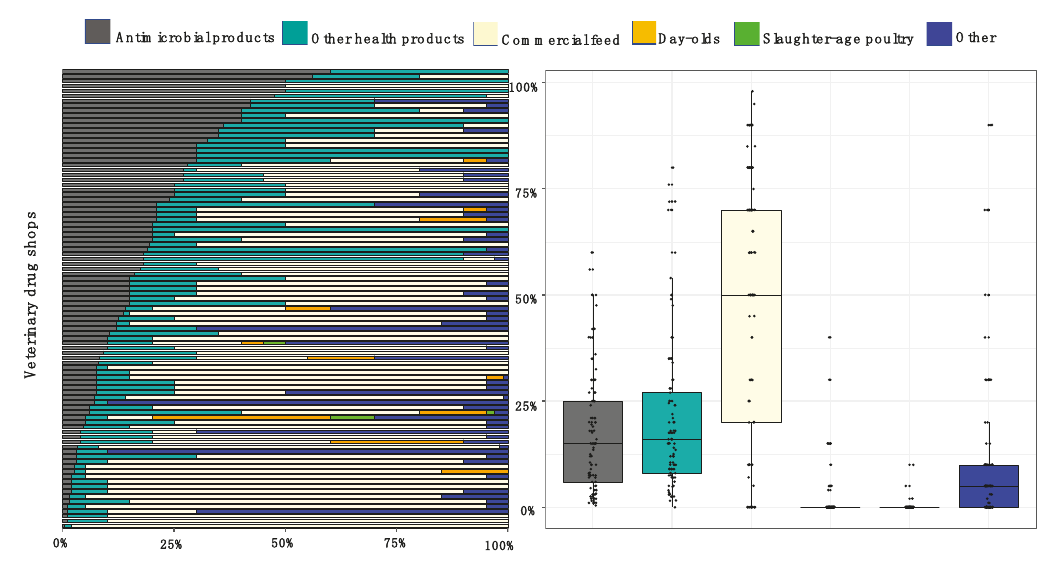
Figure 1. Types of commodities and services provided by veterinary drug shops in the study area. Each colour represents a type of commodity/service, including antimicrobials, non-antimicrobial health-supporting products, commercial feed, day-old-chicks, collection slaughter-age chickens, and ‘Other’ (services and other equipment: Drinkers, feeders, rice husks, etc.).